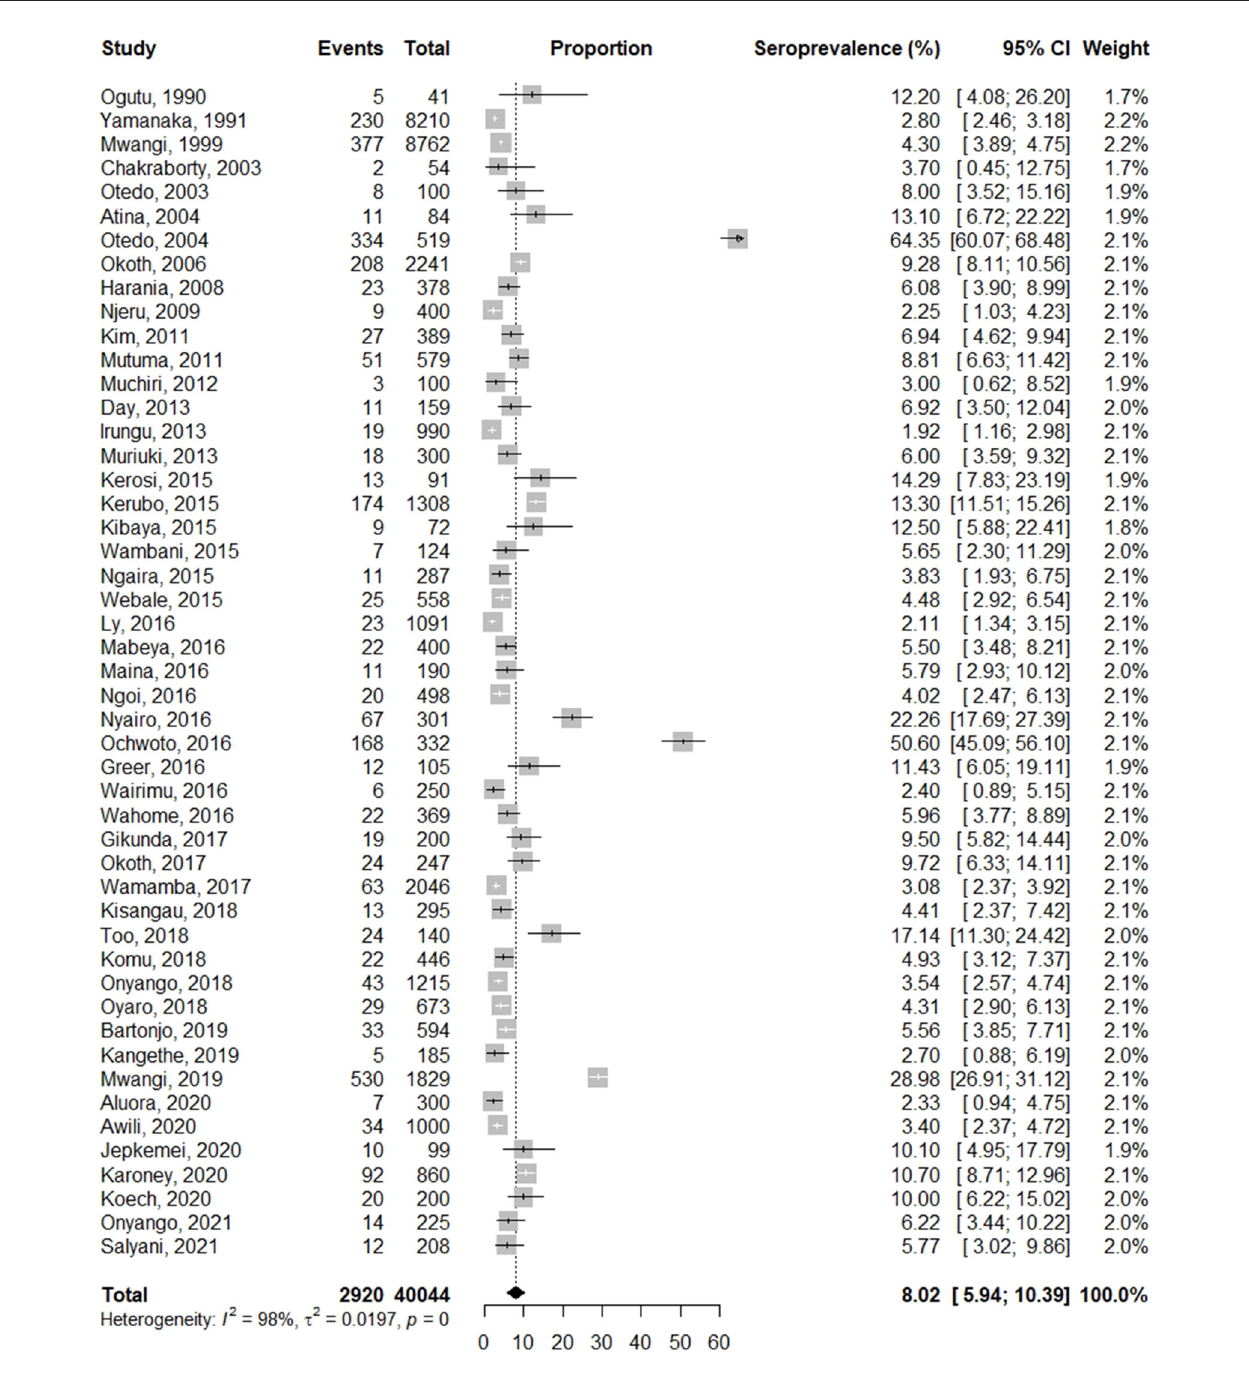
FIGURE5 Sensitivity analysis in studies reporting prevalence of HBV in